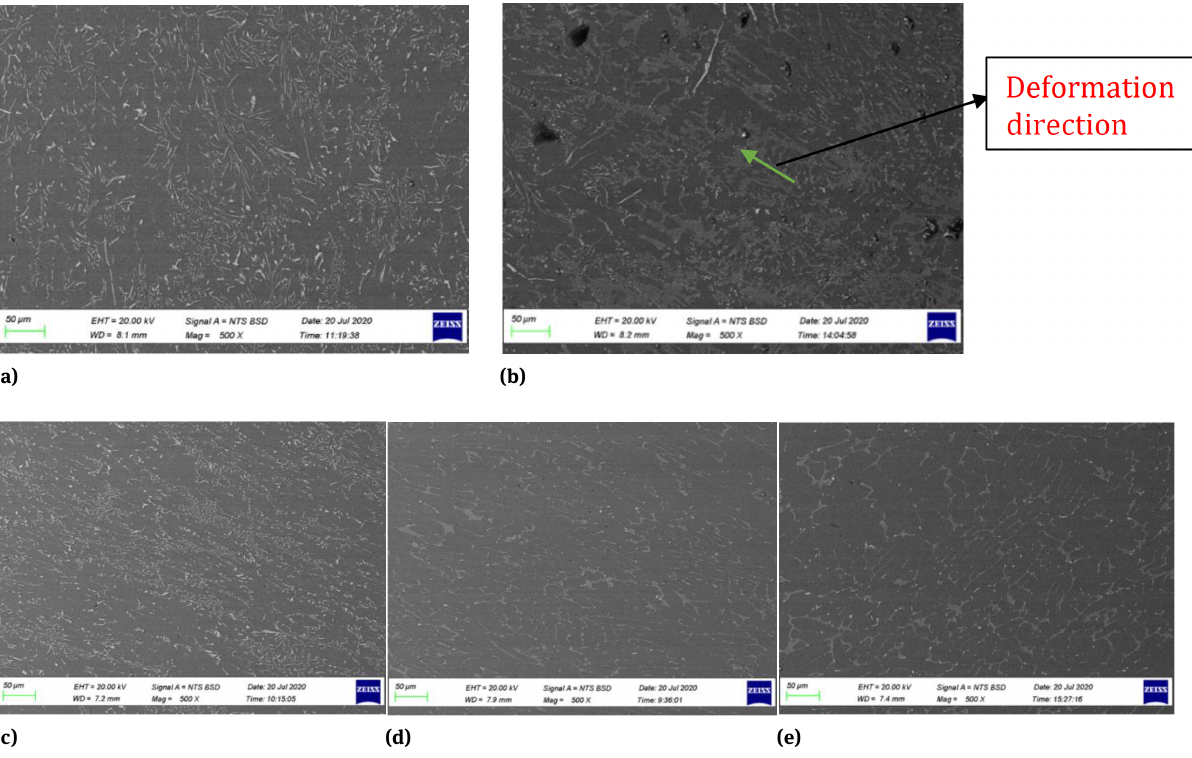
Figure 6: As-deformed microstructures of the Al6063/6 wt.% steel p composite subjected to deformation at: (a) 200 ∘ C and 0.01 s –1 ; (b) 200 ∘ C and 10 s –1 ; (c) 300 ∘ C and 10 s –1 ; (d) 300 ∘ C and 0.01 s –1 ; (e) 400 ∘ C and 10 s –1 .